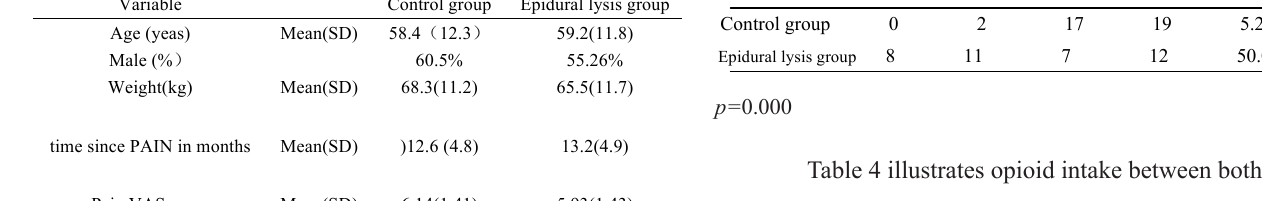
TABLE 1 - Demographic characteristics at inclusion (n=38).